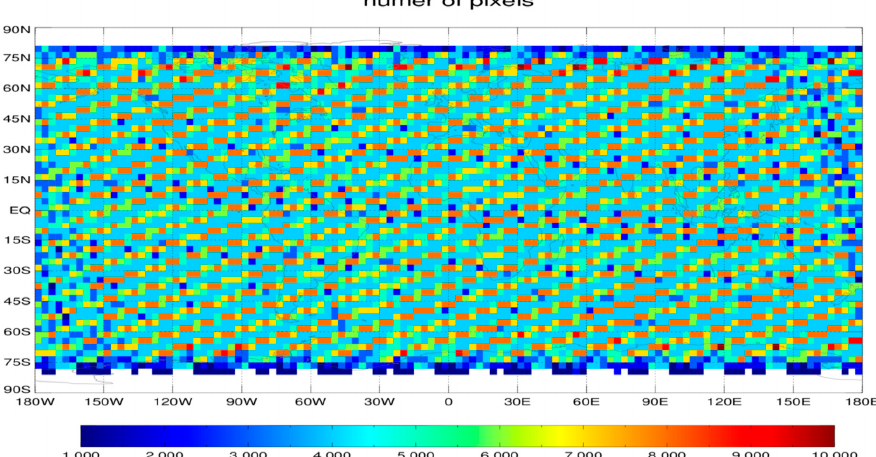
Figure 3. Global distribution of sample sizes for the 32-day accumulated radiance data per channel for SNPP NP, where the data covers the period from 1 March 2019, to 1 April